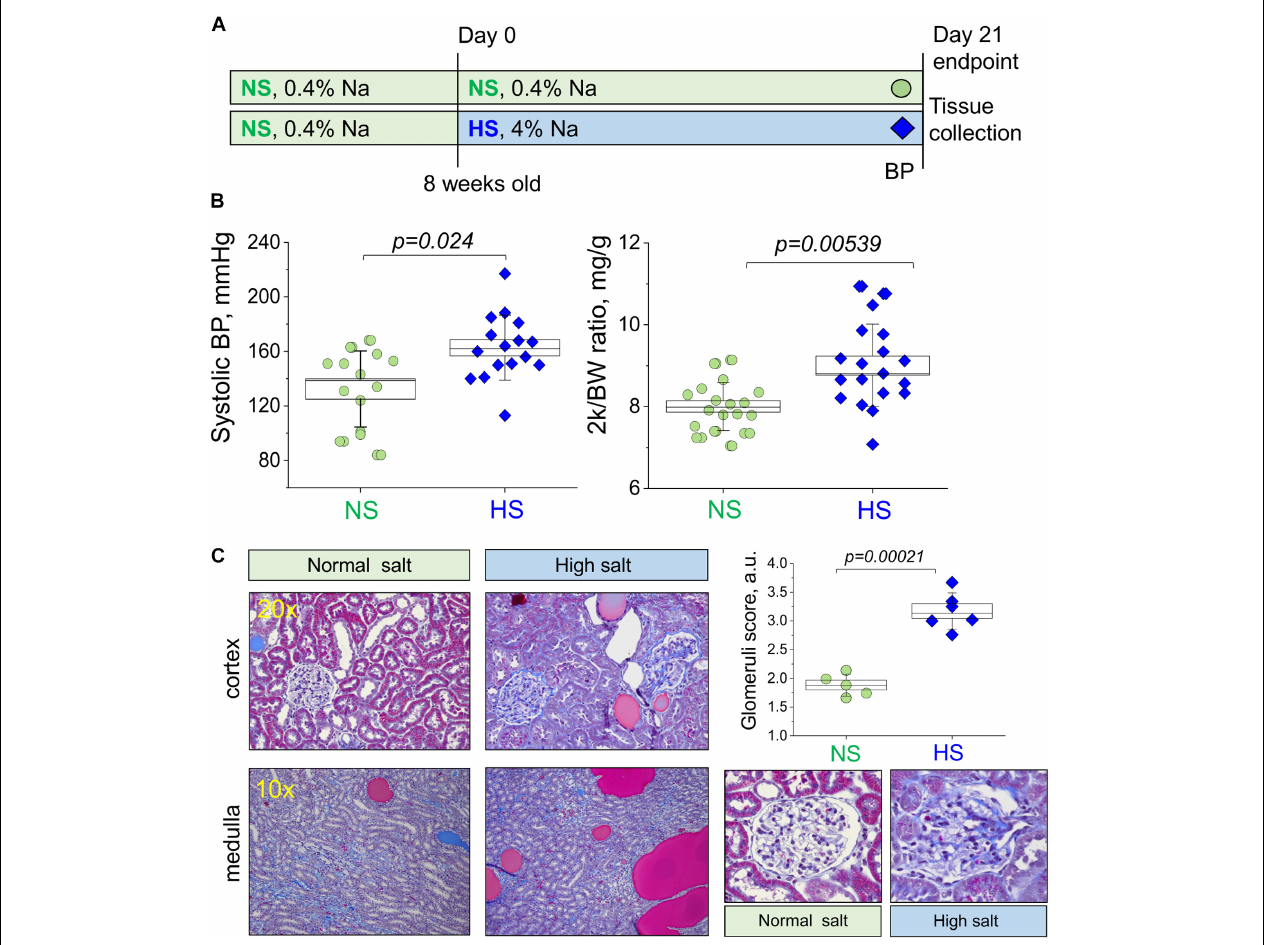
FIGURE 1 | Study protocol and development of the salt-sensitive (SS) hypertension in the Dahl SS rats. (A) Schematic representation of the experimental protocol used to induce SS hypertension in Dahl SS rats. (B) Graphs illustrating the observed increase in systolic blood pressure (systolic BP, left ) and two kidney to body weight ratio (middle panel, 2 k/BW) in the NS diet fed group compared to a HS diet fed group (right). (C) Representative histological images showing cortical renal tissues (20 × ) and medullary tissues (10 × ) from NS and HS diet fed animals stained with Masson’s trichrome. Graph illustrates summarized glomerular damage score (glomeruli examples are provided below for each experimental group). All data were compared using a one-way ANOVA with Holm–Sidak post hoc test. In Graphs (B) , each data point represents a single measurement from an experimental animal at the end of the protocol after the NS or HS challenges. For the glomerular damage score (C) , each point is an average of 100 glomeruli blindly scored in the renal tissue of each animal. NS, normal salt; HS, high